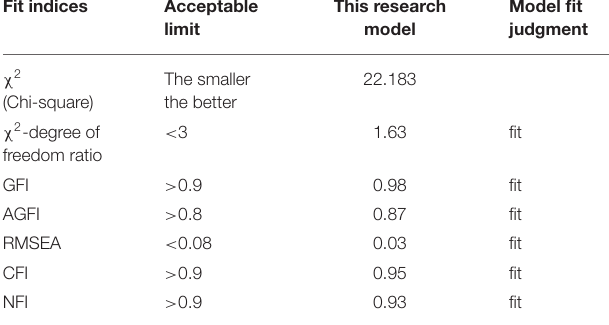
TABLE 2 | Model fit